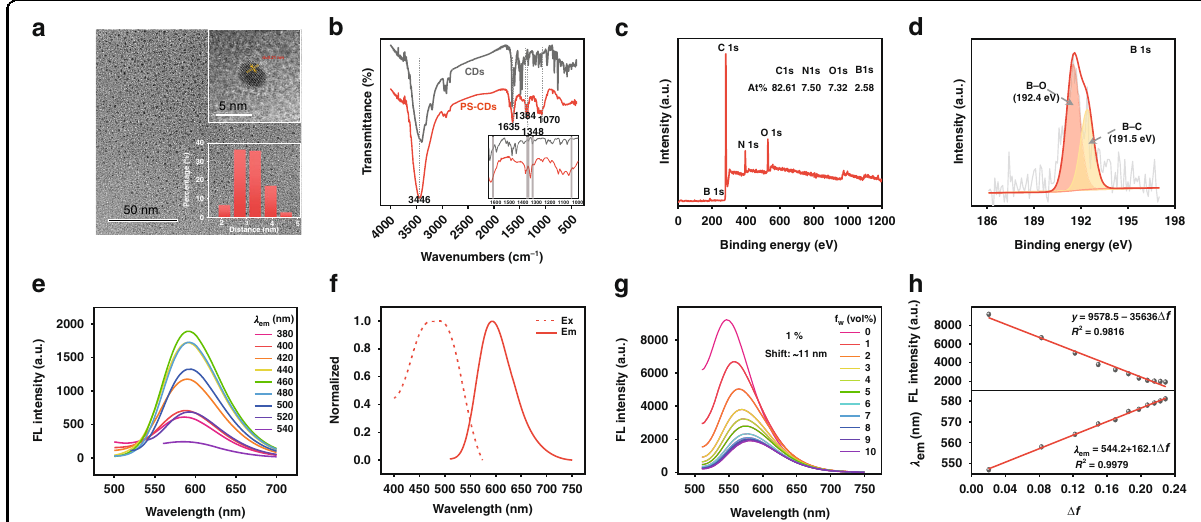
Fig. 2 Morphological, structural characterization, absorption, and fl uorescence spectra of PS-CDs. a TEM and HRTEM images of PS-CDs with size distribution. b FT-IR spectroscopy of PS-CDs and CDs. c XPS survey spectrum of PS-CDs. d B 1s XPS spectrum of PS-CDs. e Different wavelengths of excitation in fl uence the fl uorescent emission spectra of PS-CDs. f The emission and excitation spectra of PS-CDs. g Emission spectrum of PS-CDs in various 1,4-dioxane/H 2 O ratios (0 – 10%). h Linearity of the maximum emission wavelength, maximum emission fl uorescence intensity, and